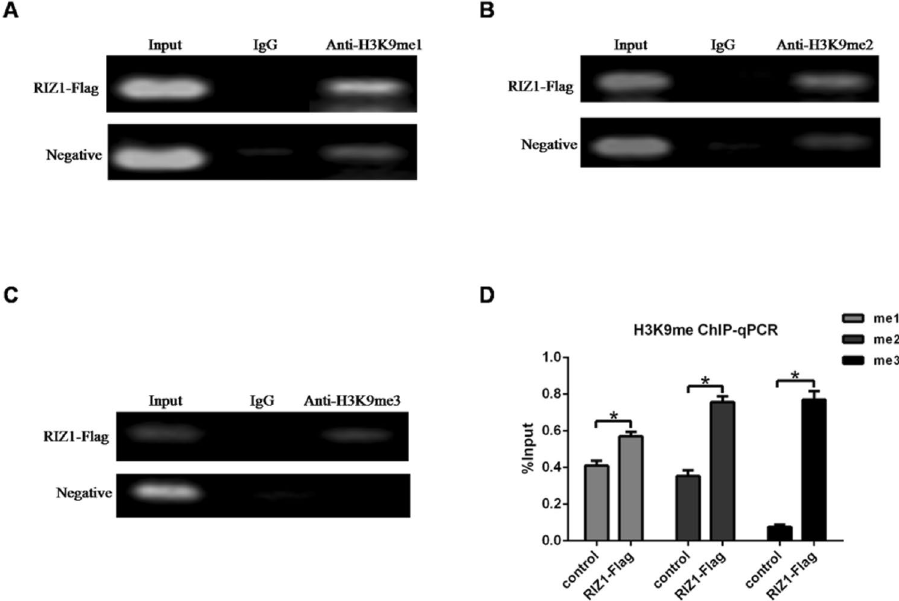
Figure 5. RIZ1 effect on H3K9 methylation on Akt3 promoter. ChIP assays using anti-H3K9me1 ( A ), anti- H3K9me2 ( B ), anti-H3K9me3 ( C ) antibodies were performed with HEK293 cells overexpressing Flag-tagged RIZ1. ChIP-qPCR assay was also performed ( D ). Data represent mean ± SD of triplicate measurements. * p <